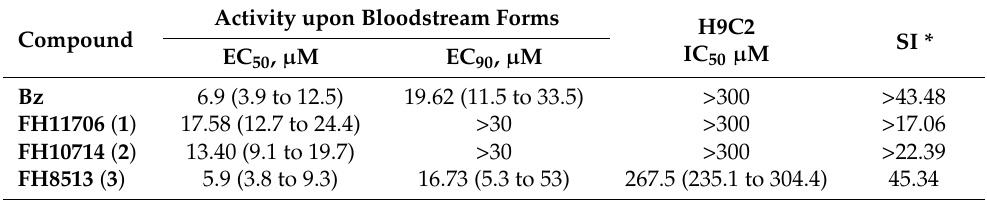
Table 2. Activity of the studied compounds against bloodstream trypomastigotes of T. cruzi (Y strain), toxicity on H9C2 and respective selective indexes (SI) after 24 h of compound incubation. Activity upon Bloodstream Compound